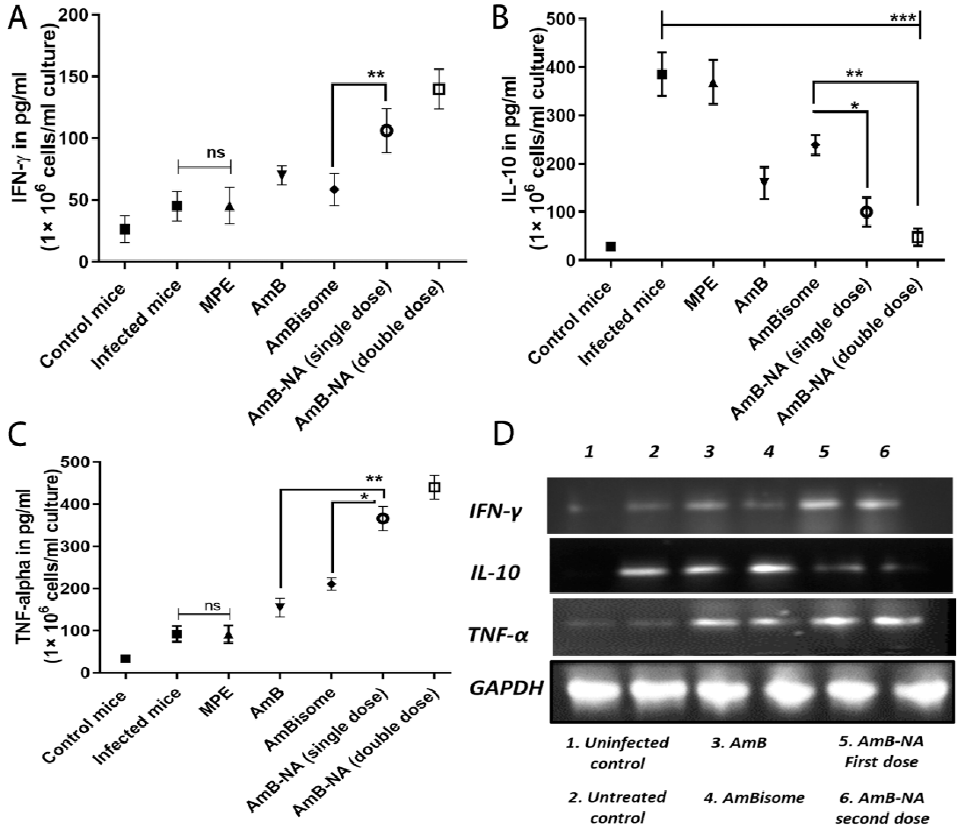
Figure 9. Assessment of the pro-inflammatory potential of AmB-NA against murine visceral leish- maniasis. Four-week post-treatment splenocytes from different study groups (uninfected, infected, and various drug-treated BALB/c mice) were cultured and incubated in a CO 2 incubator in the presence of 48 h SLA stimulation at 37 ◦ C. Cell-free supernatant was used to evaluate cytokine profile through ELISA ( A ) IFN- γ , ( B ) IL-10, and ( C ). TNF- ∝ (Data represented as means ± SE for six mice per group and are representative of two independent experiments with similar results. * p < 0.05, ** p < 0.01, *** p < 0.001), ns = non-significant, and ( D ) Semiquantitative PCR for genes specific for mice IFN- γ , IL-12, IL-10, and